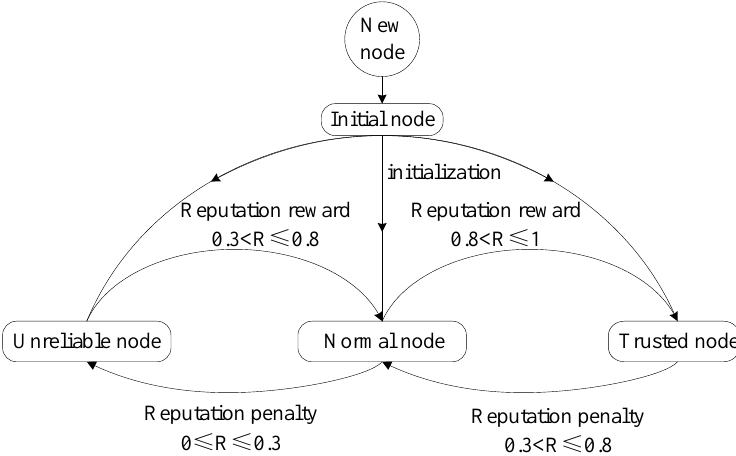
Figure 3. Dynamic reputation level transformation diagram of